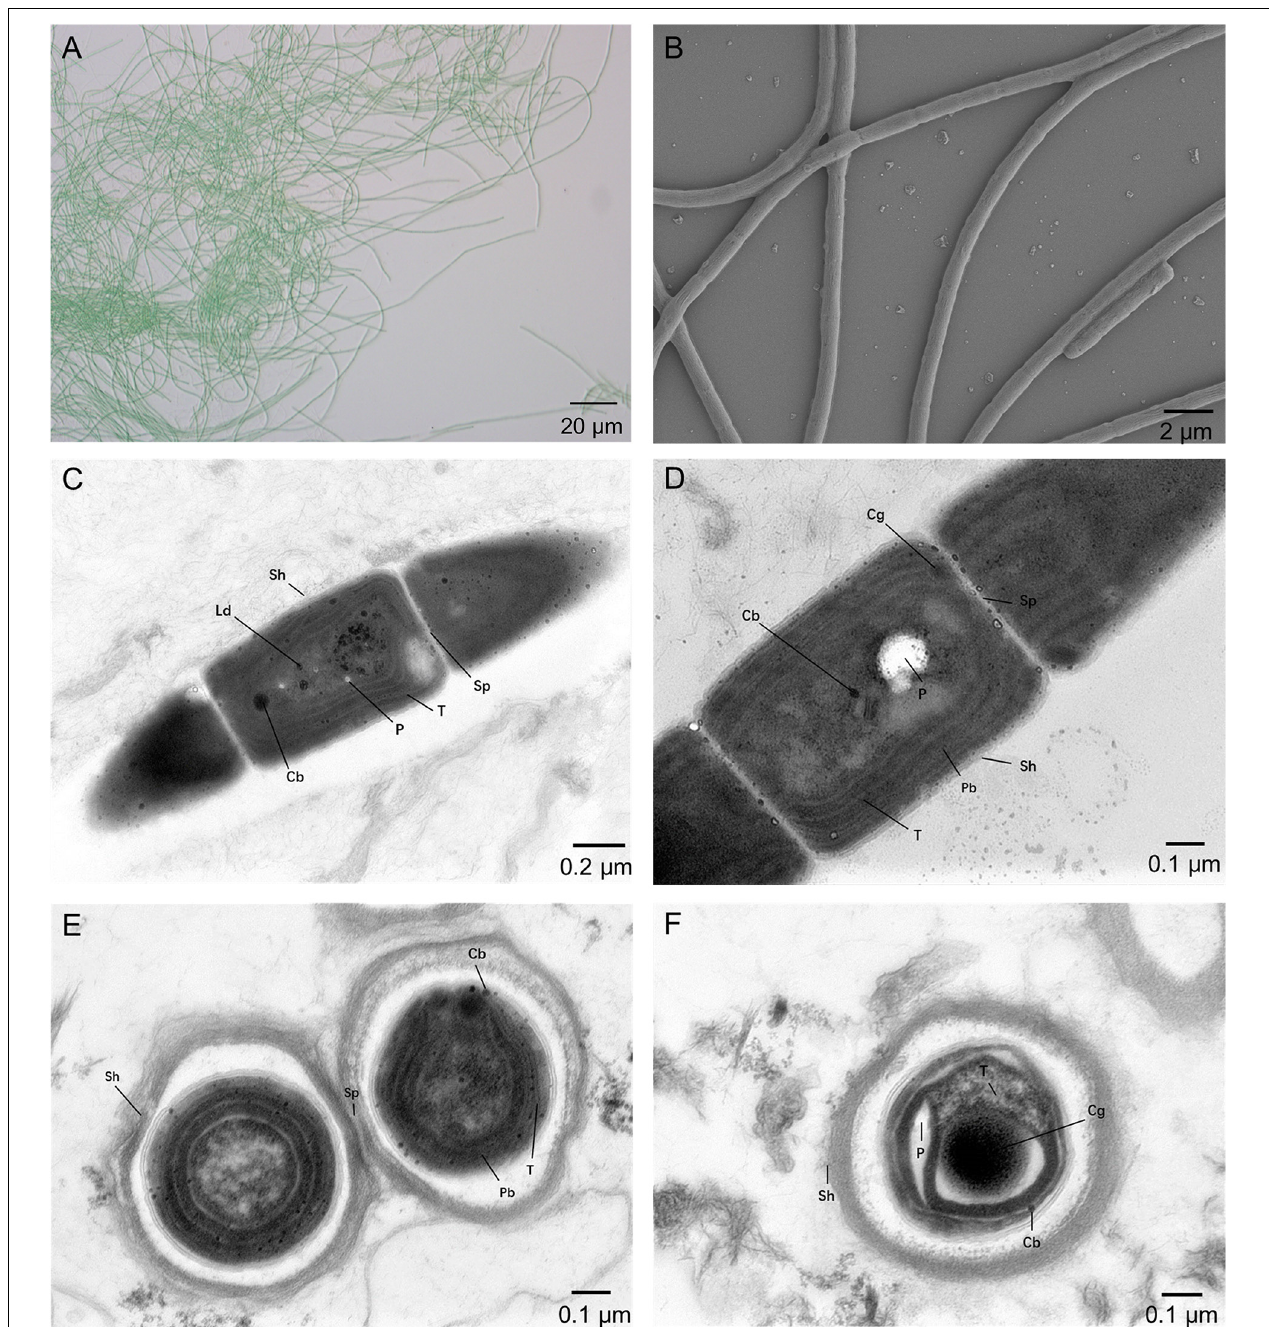
FIGURE 1 | Micrographs of A183. (A) Light microscopy image. (B) SEM image. (C–F) TEM images. Cb, carboxysome; Cg, cyanophycin granule; Cn, cyanophycin granule; Ld, lipid droplet; P, polyphosphate body; Pb, phycobilisome; Sh, sheath; Sp, septum; T, thylakoid membrane. Magnifications: 400 × (A) , 5,000 × (B) , 8,000 × (C) , and 12,000 × (D–F)